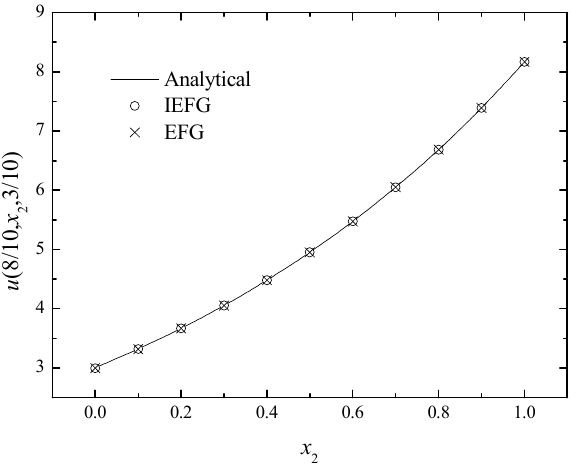
Figure 9. The comparison of numerical and exact solutions along x 2 -axis.